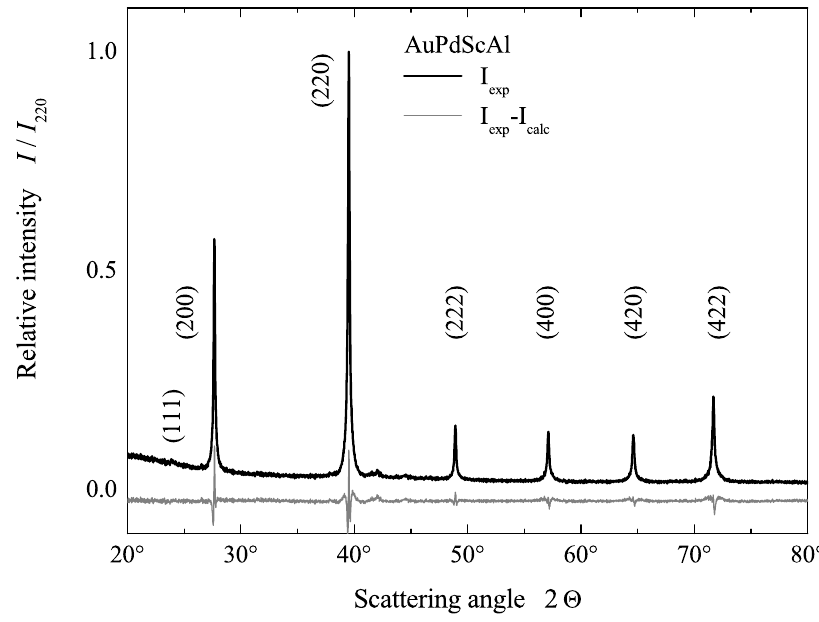
Figure 3. Powder X-ray diffraction of AuPdScAl. The figure shows the observed diffraction data (black). The difference curve (grey) shows the difference between the observed data and the Rietveld refinement. The measurement was performed at room temperature ( ≈ 300